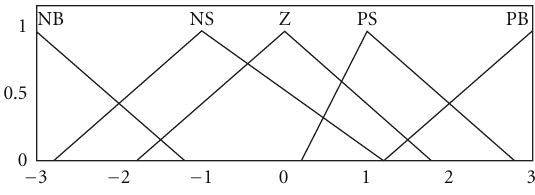
Figure 6: Fuzzy controller input variable “ ce ”.